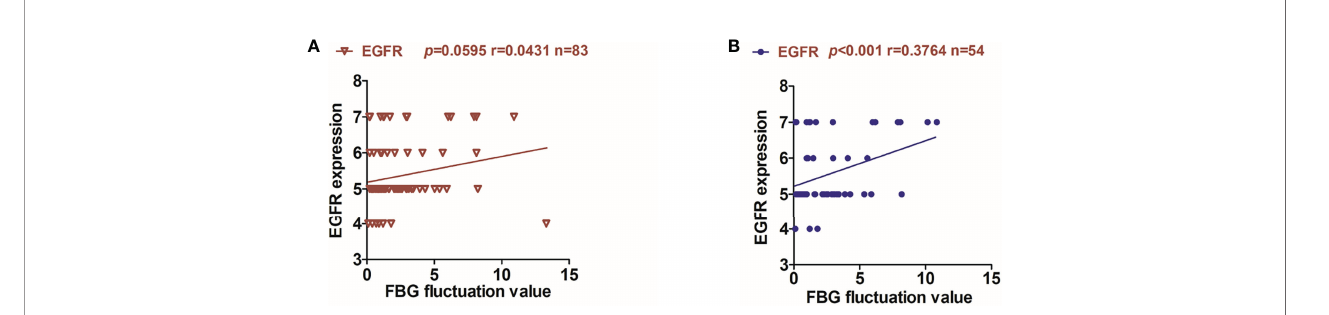
FIGURE 2 | Relationship between EGFR expression and fl uctuation of FBG in OSCC patients. (A) correlation between the FBG fl uctuation of 83 patients and the expression of EGFR. (B) correlation between the FBG fl uctuation of 54 patients and the expression of EGFR in OSCC-DM group.